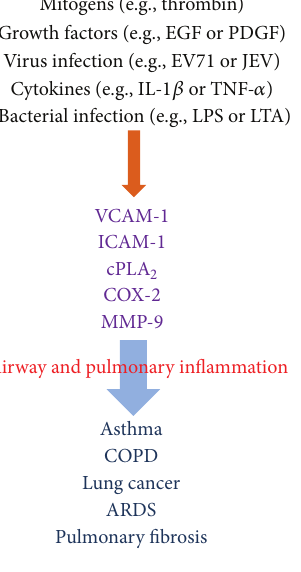
Figure 1: General overview of the inflammatory target proteins in respiratory diseases. Many of the known inflammatory target pro- teins, such as MMP-9, ICAM-1, VCAM-1, COX-2, and cPLA 2 , are induced by various stimuli, such as mitogens, growth factors, virus infection, cytokines, and bacterial infection. EGF, epidermal growth factor; PDGF, platelet derived growth factor; EV71, enterovirus 71; JEV, Japanese encephalitis virus; IL-1 𝛽 , interleukin-1 𝛽 ; TNF- 𝛼 , tumor necrosis factor- 𝛼 ; LPS, lipopolysaccharide; LTA, lipoteichoic